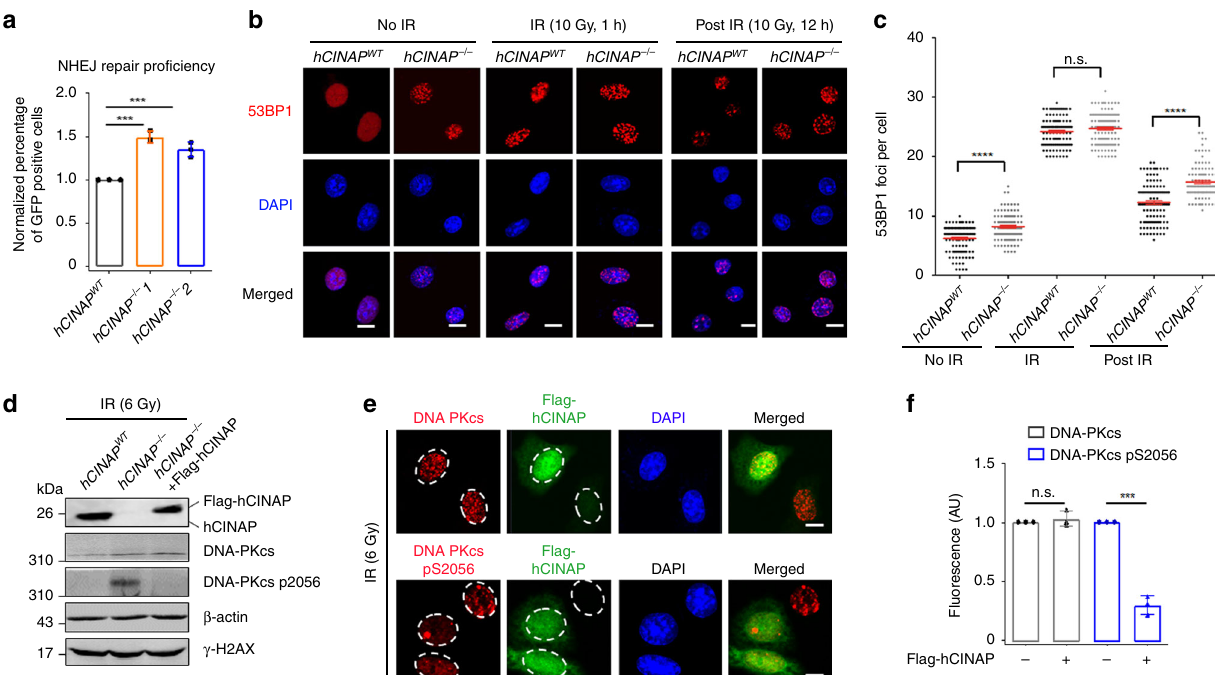
Fig. 7 Deletion of hCINAP increases the ef fi ciency of error-prone NHEJ. a hCINAP WT and hCINAP − / − HEK293T cells were subjected to NHEJ assays. Data are presented as the mean ± SEM of three biological replicates. More than 1000 cells were counted in each experimental group. The positive cell percentage was compared with the control group, two-tailed students ’ t test, ** P < 0.01, *** P < 0.001. b , c hCINAP WT and hCINAP − / − U2OS cells were subjected to 10 Gy IR and immunostained with anti-53BP1 antibodies. Representative immuno fl uorescence images are shown in b and the statistical analysis of 53BP1 foci in each group were counted c . The results are presented as the mean ± SEM of three biological replicates. Statistical analysis was performed using the Student ’ s t test; **** P < 0.0001. Approximately, 100 cells in each group were counted. d Different HEK293T cells were exposed to 6 Gy IR and recovered for 1 h, and then the levels of DNA-PKcs and phosphorylated DNA-PKcs Ser2056 were assessed by immunoblotting using the indicated antibodies. e , f HeLa cells transfected with Flag-empty vector or Flag-hCINAP were treated with IR (6 Gy) and recovered for 1 h, and then immuno fl uorescence assays were performed using anti-DNA-PKcs, anti-phosphor-DNA-PKcs Ser2056, and anti-Flag antibodies. Scale bar, 10 μ m. Quanti fi cation analysis was performed using ImageJ software. Statistical analysis was performed using Student ’ s t test (*** P < 0.001). About 50 cells were counted in each group. Unprocessed scans of blots are provided in Supplementary Fig.